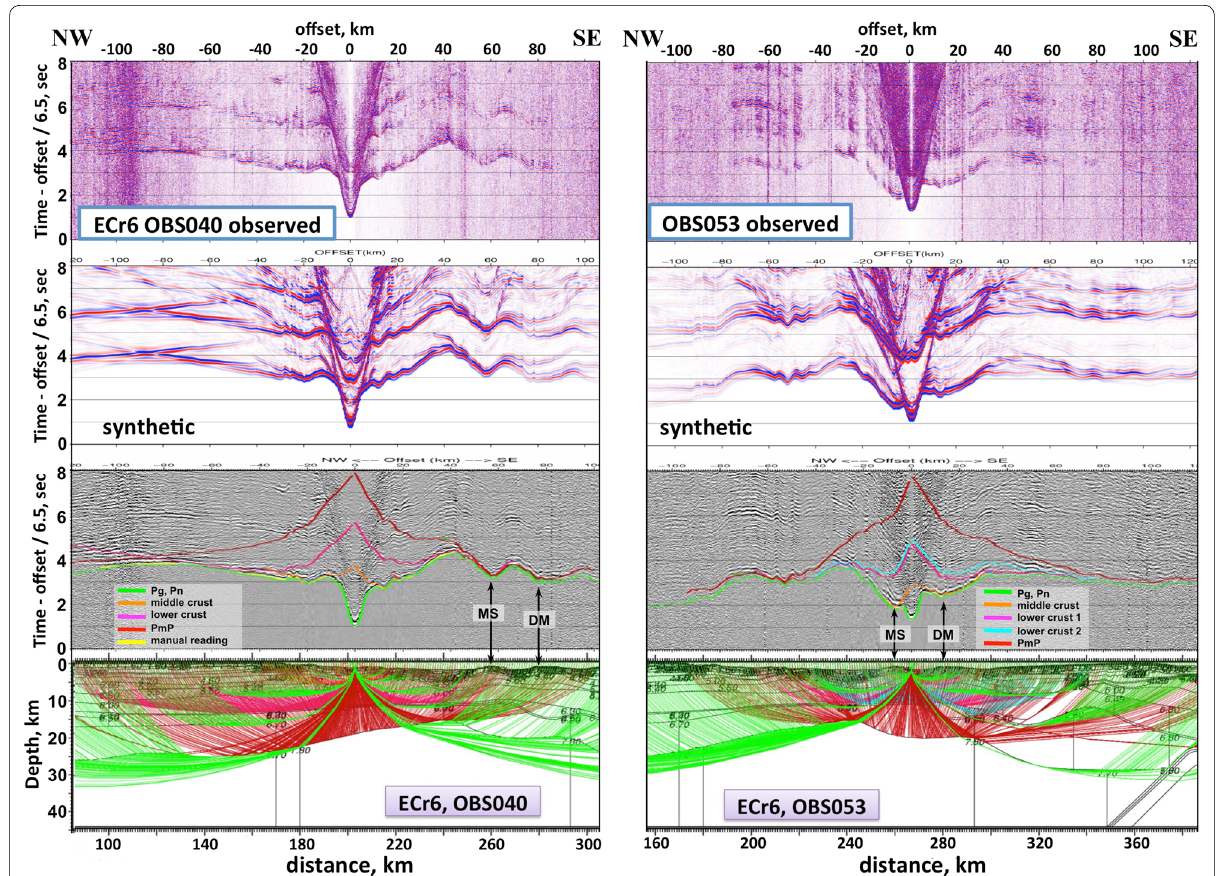
Fig. 9 Example of forward modeling for ECr6. From top to bottom, observed record sections, synthetic seismograms, and travel time fitting with ray diagrams for OBS040 (left) and OBS053 (right), respectively. The colors of the calculated travel times on the record sections correspond to the ray paths in the ray diagrams. The ray paths are generated at equal distance. The positions of the OBS040 and OBS053 are indicated by blue inverse triangles in Fig. 2. DM Daiichi–Miyako Knoll, MS Miyako